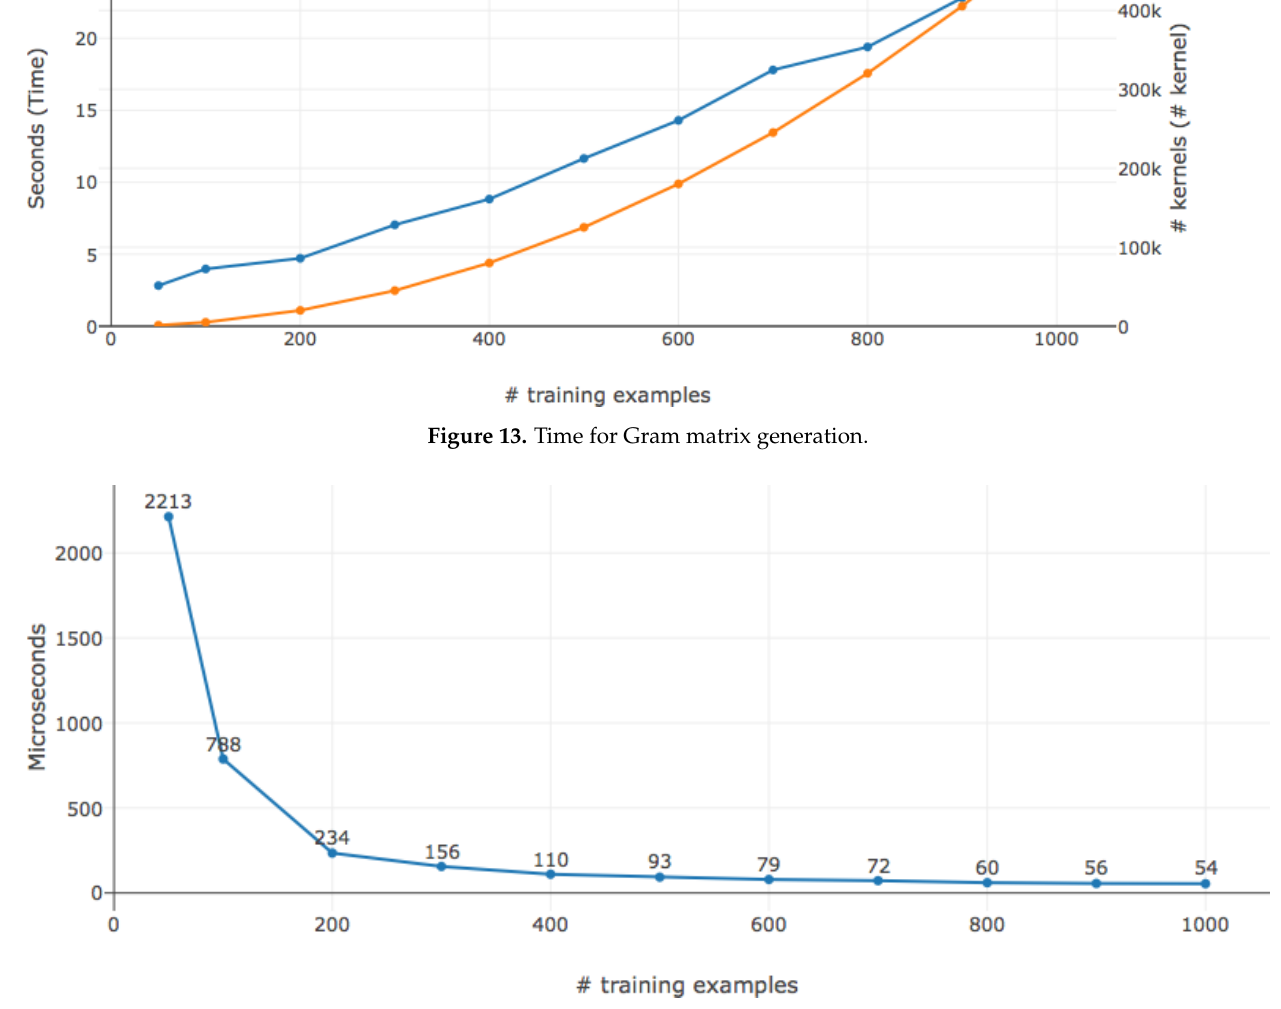
Figure 14. Time for kernel computation per kernel